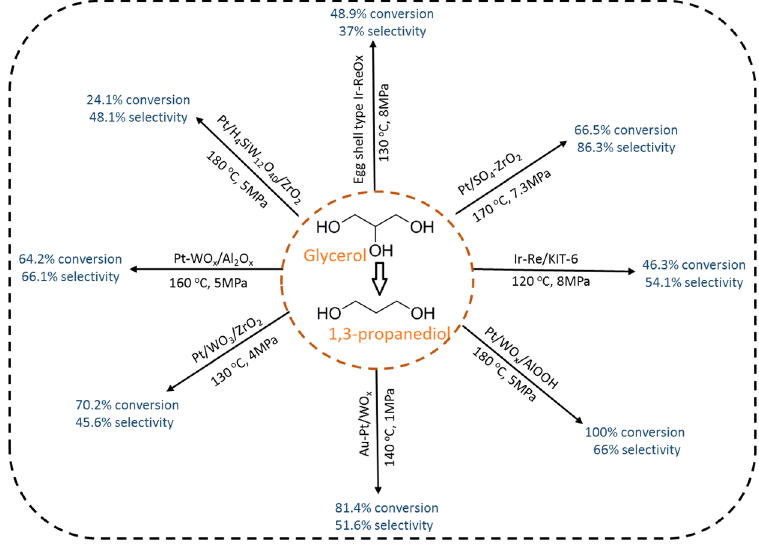
Figure 1. Catalysts investigated for glycerol hydrogenolysis to 1,3-PDO in